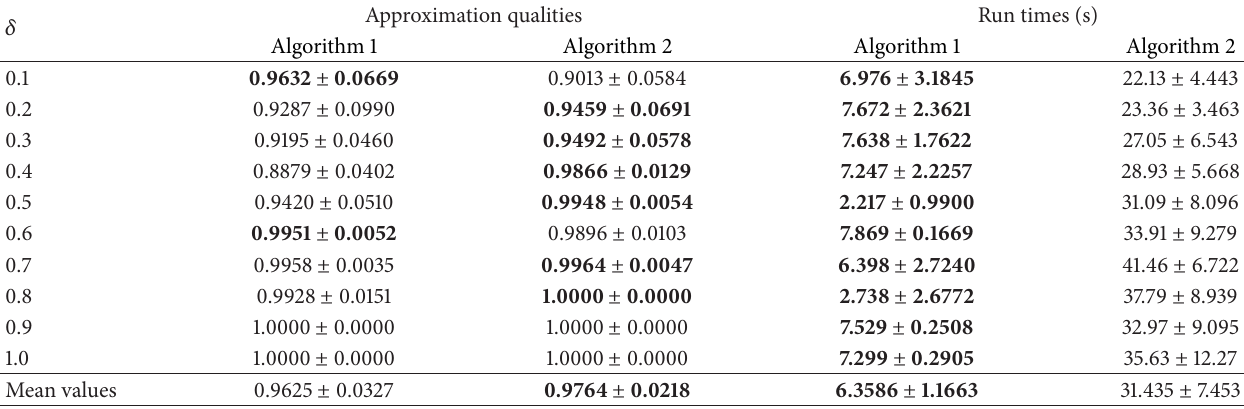
Table 8: The comparison between decision-monotonicity criterion based reducts and cost based reducts (Soybean).